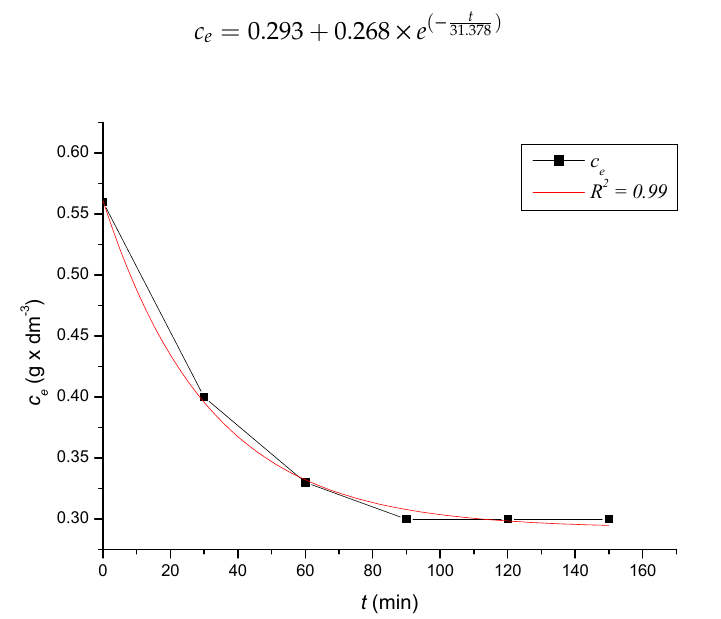
Figure 3. The kinetic course of reducing the concentration of Fe 3+ cations in a solution with an initial concentration of 0.56 g × dm −3 by the action of clinoptilolite.